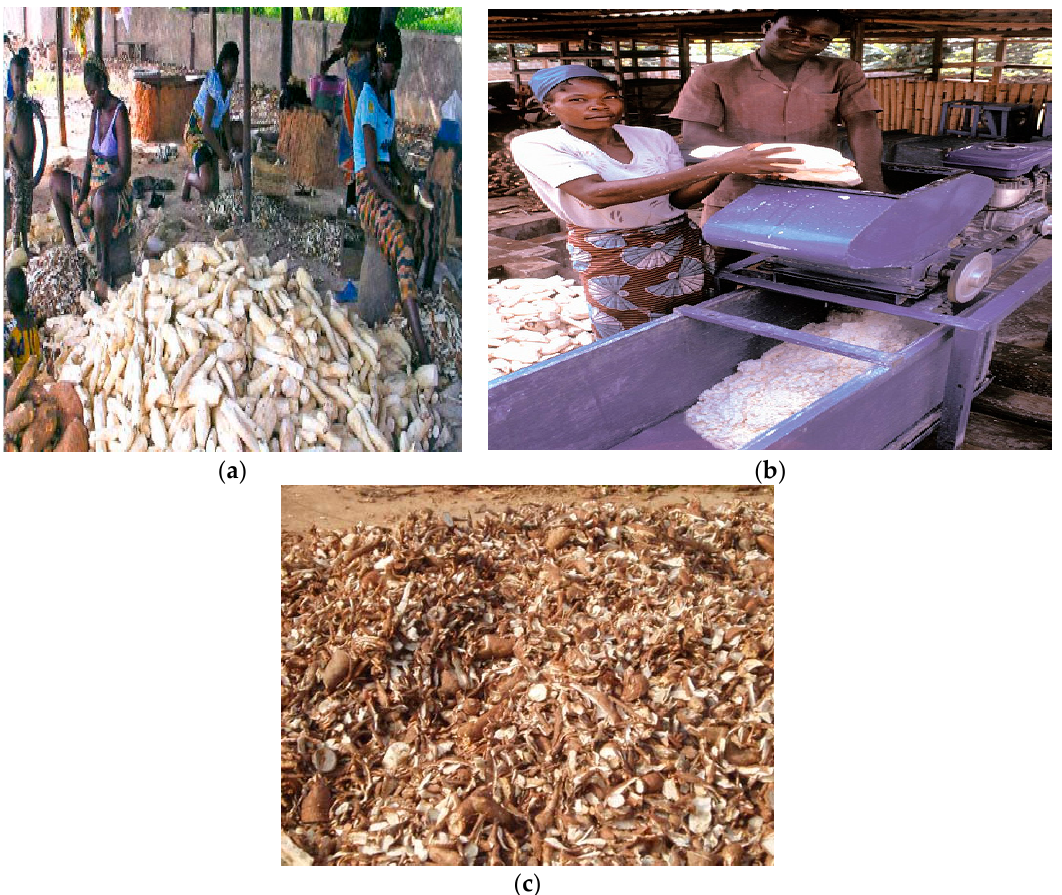
Figure 3. Activities in the Cassava Processing Factory. ( a ) Cassava peeling section; ( b ) Cassava grinding machine in operation; (c) Cassava peel dump site.